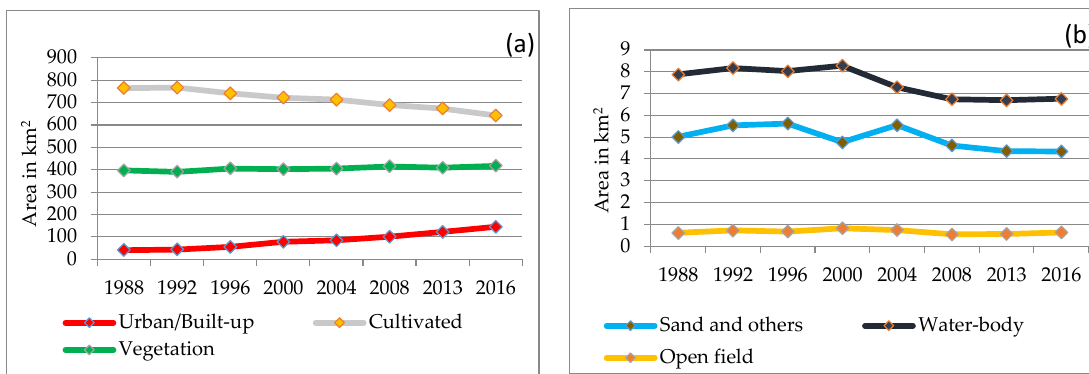
Figure 5. Trend of LULC change ( a ) Urban built-up, cultivated land, and vegetation cover; ( b ) sand and others, water body, and open field.